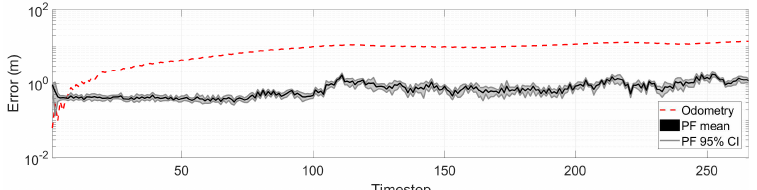
Figure 10. Pose tracking error and odometry-only error. See Section 6.5 in the text for more